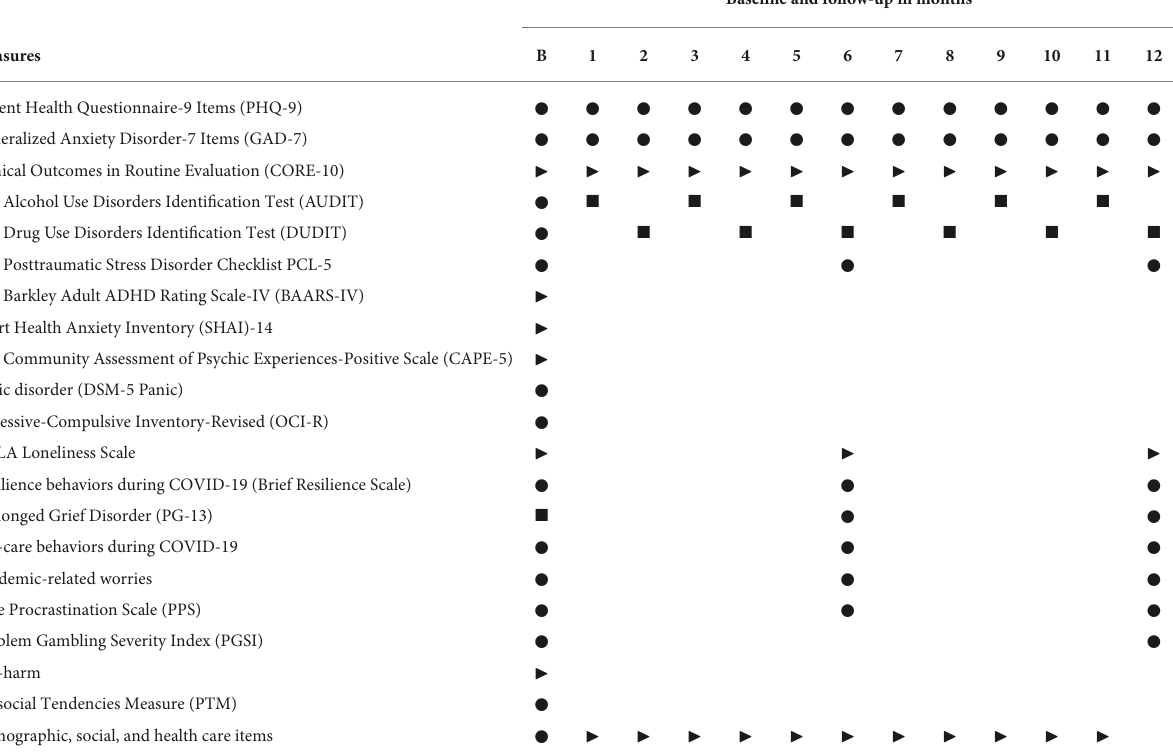
TABLE 1 Overview of data collection structure.